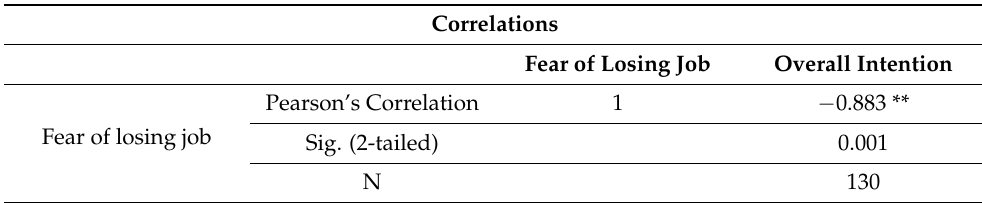
Table 5. Correlations between V4 non-EU resident workers’ fears of losing job in case of working from home and their intention to work from